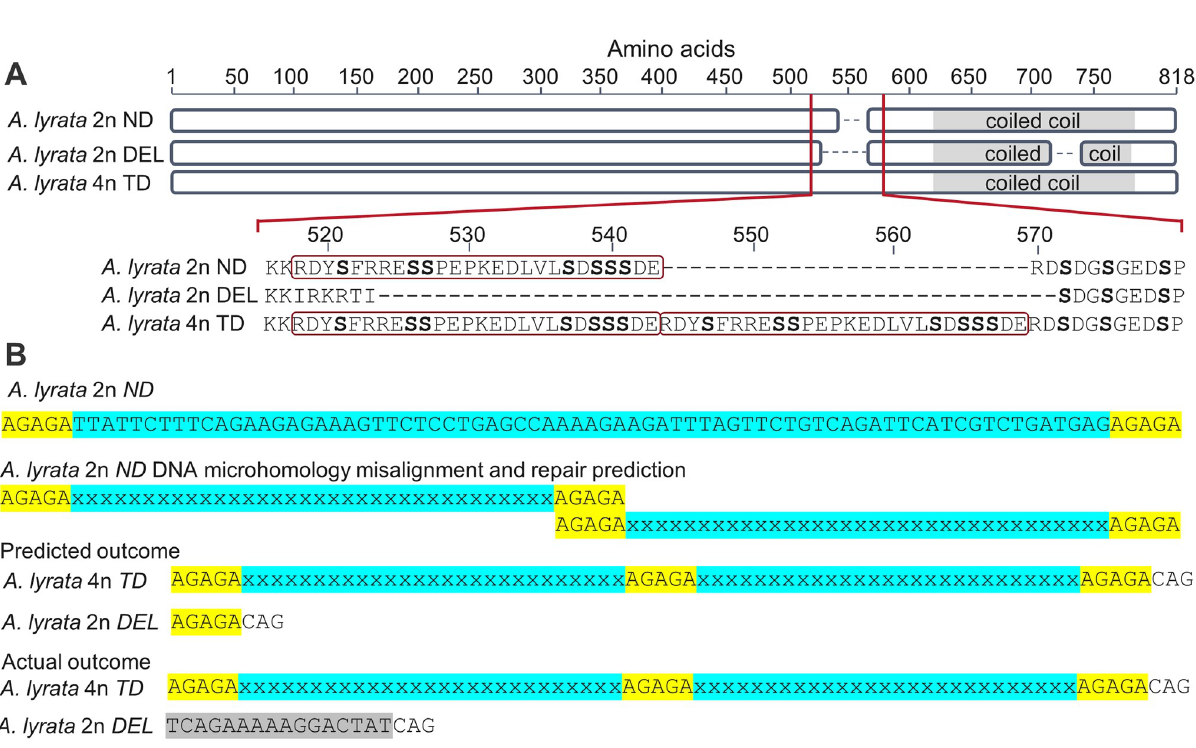
Fig 4. Structural variants of the three major A . lyrata ASY3 alleles. (A) The serine-rich region (red box) with serines highlighted in bold in the non- duplicated (ND) ancestral diploid allele, absence in the deletion (DEL) diploid allele and tandemly duplicated (TD) in the derived tetraploid allele possessing two serine-rich regions (red boxes) as well as putative SUMO sites at K517, K531 and K556. (B) Major structural variation at the ASY3 locus suggesting that misalignment by DNA microhomology (highlighted yellow) and recombinational repair between the ancestral ND alleles may have led to the formation of the TD allele (blue = region of duplication). The outcome does not quite match the prediction as there are bases of unknown origin in the DEL allele (shaded in grey), but formation of these alleles may be independent events. The x’s highlighted in blue represent bases between the AGAGA sites as shown for A . lyrata 2n ND